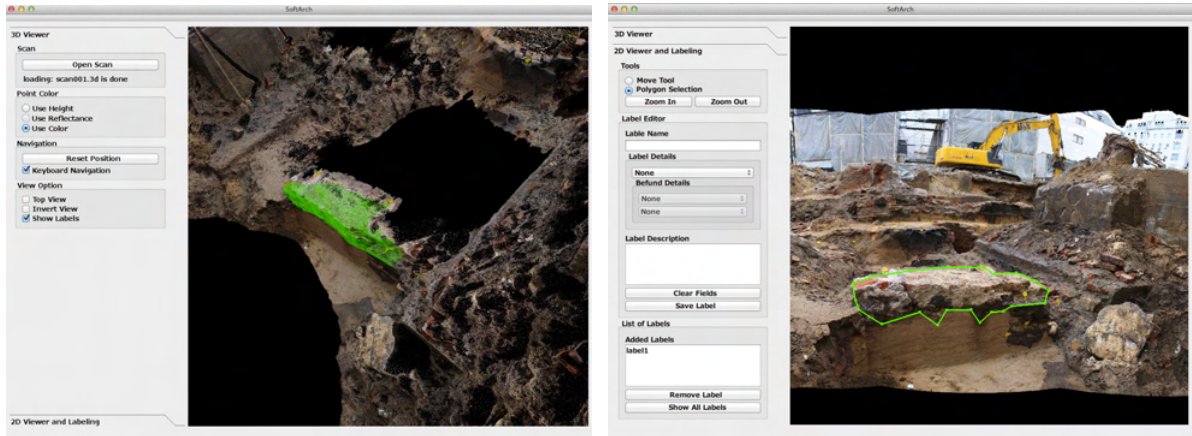
Figure 4: A presentation of a selected region of interest of a scan in the 3D viewer (left) and in the 2D viewer of the Castle3D software. The scan has been taken at an excavation site in Bremen, Germany.